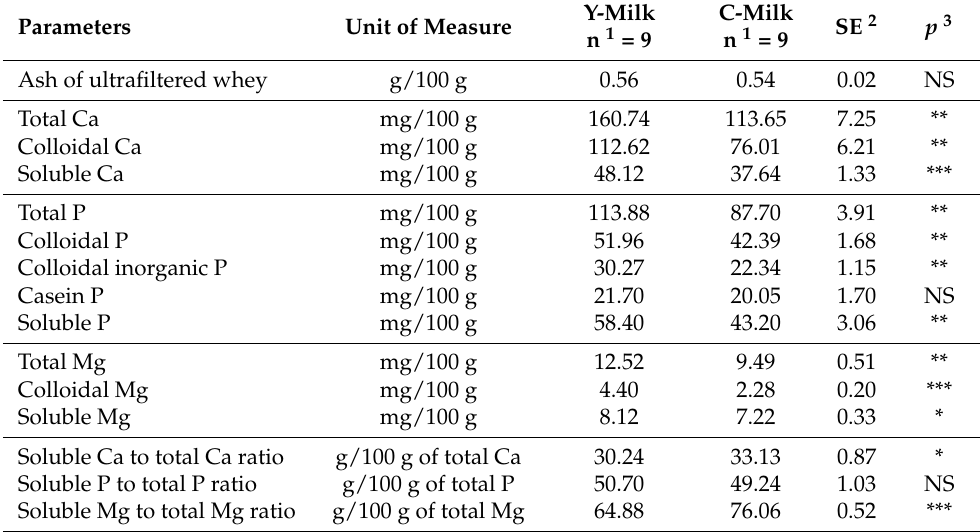
Table 2. Least-square means of Ca, P and Mg contents and distribution between the colloidal and the soluble phases of yak ( Bos grunniens , Y-milk) and cow ( Bos taurus , C-milk) milk.